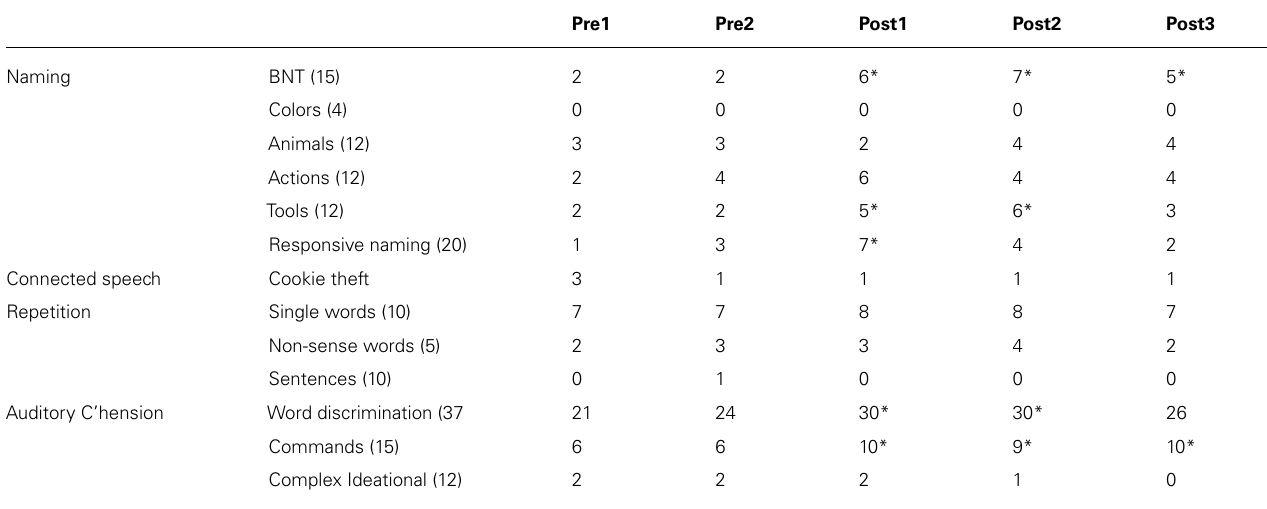
Table 2 | BDAE scores for participant 001.